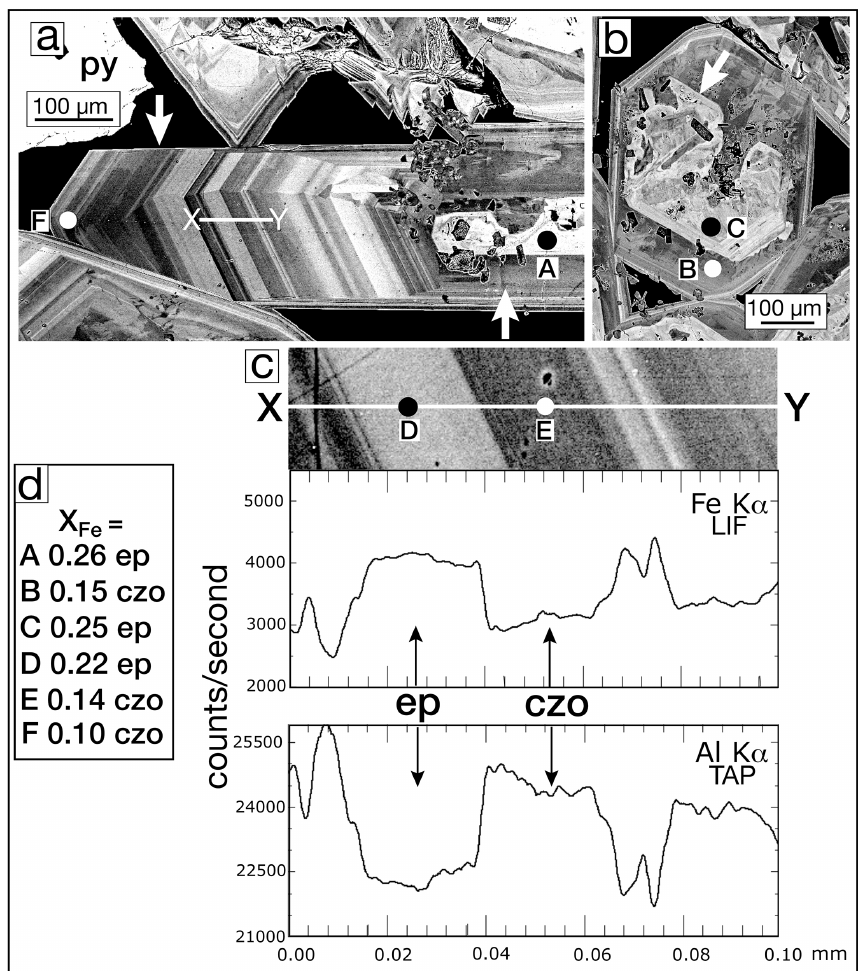
Figure 7. BSE images: (a) several millimeter-long, complexly zoned epidote crystals from sample SV3-2353. The left arrow indicates oscillatory growth in the b -crystallographic direction of the euhedral elongate crystal. The core of the crystal (right arrow) has an irregularly shaped iron-rich core. The line X–Y is the traverse shown in Fig. 7c. (b) A basal section of a complexly zoned epidote crystal showing an iron-rich core (arrow) that has been partially resorbed. The dark areas in the core are biotite crystals. (c) Enlarged detail of the EPMA traverse shown in Fig. 7a. The EPMA line traverses for the elements Fe and Al are shown below registered in position. The Fe-rich bands are epidote (ep), and Al-rich bands are clinozoisite (czo). The conditions of the EPMA line traverse were 15keV and 30nA, with a pixel size of ∼ 0.1µm. The excitation of the sample with the electron beam is a tear-drop-shaped volume so that as the beam traverses from one section to another, the boundaries are sloped. (d) Values of X Fe [(Fe 3 + ) / (Fe 3 + + Al)]apfu for the EPMA analytical spots A–F for epidote (ep)